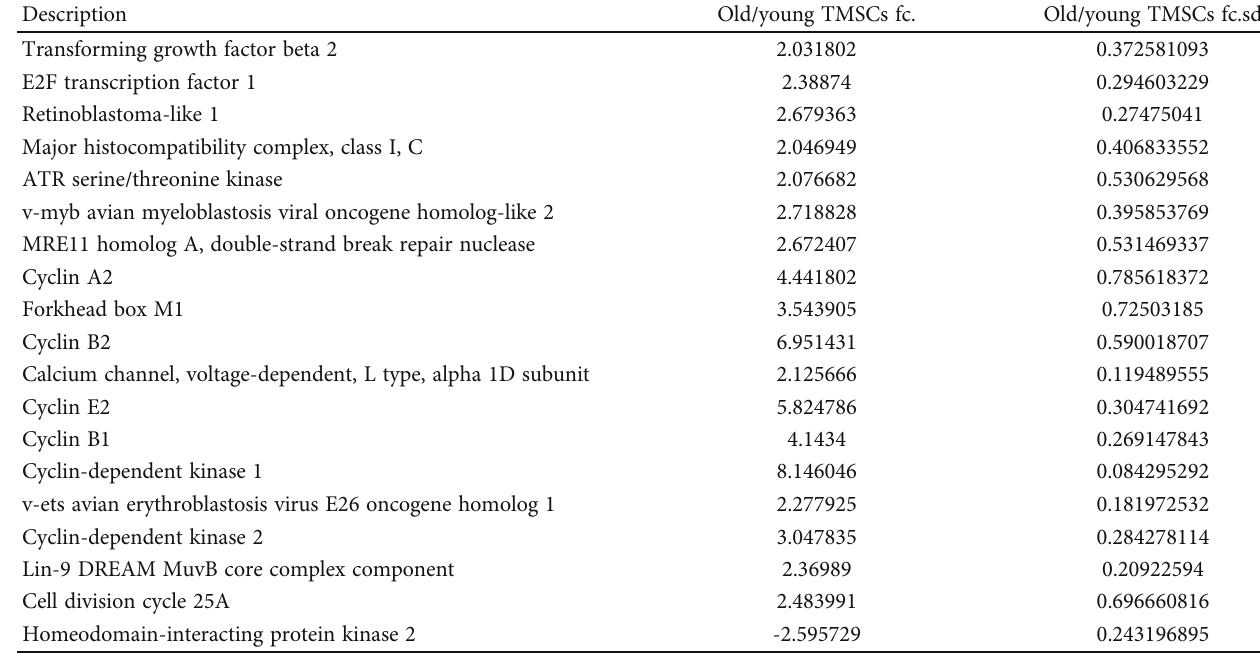
Table 1: List of cell cycle related-heatmap component